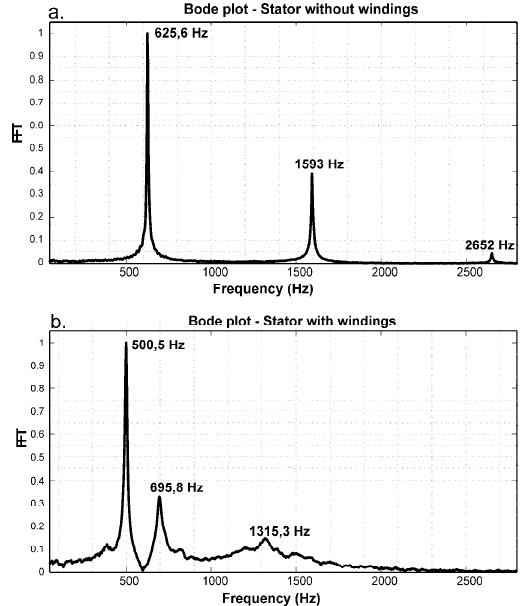
Figure 5. Experimental results of natural frequencies measured for: a ) stator stack without windings and b ) stator stack with the slot windings and end-windings. and b ) stator stack with the slot windings and